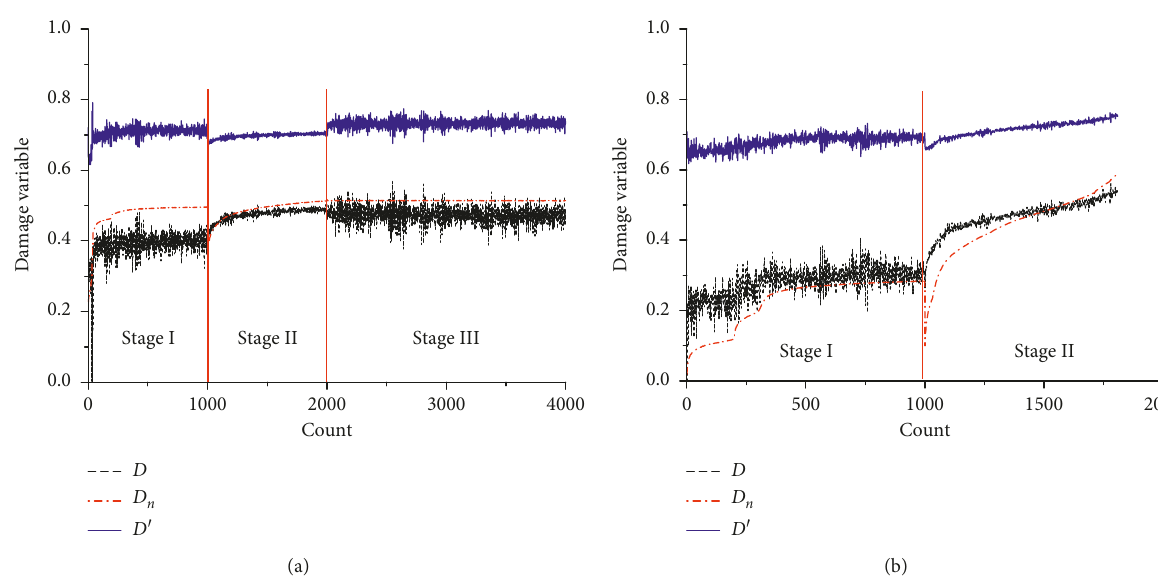
Figure 12: Diagram of comparison between different damage scalars. (a) Undamaged sample. (b) Damaged